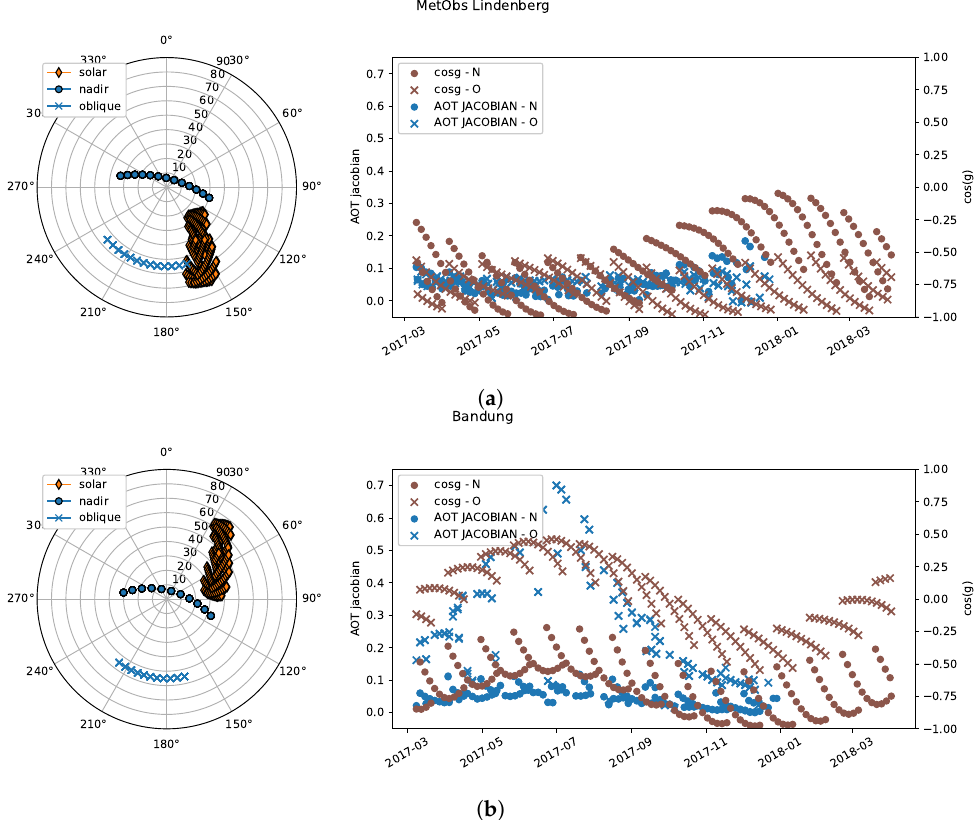
Figure 5. The polar plots ( a ) show the acquisition geometry over Lindenberg, Germany (52.209 ◦ N, 14.121 ◦ E) and Bandung, Australia (6.888 ◦ S, 107.610 ◦ E). The orange diamonds represent the solar angles, blue symbols represent the viewing angles. Circles represent the zenith angle and polar angles represent azimuth angles with zero azimuth pointing to the north. ( b ) The time series of the aerosol optical thickness (AOT) Jacobians (blue, left axis) and the cosine of the scattering angle (brown, right axis) from March 2017 to March 2018. Dots and crosses represent the nadir and oblique views,